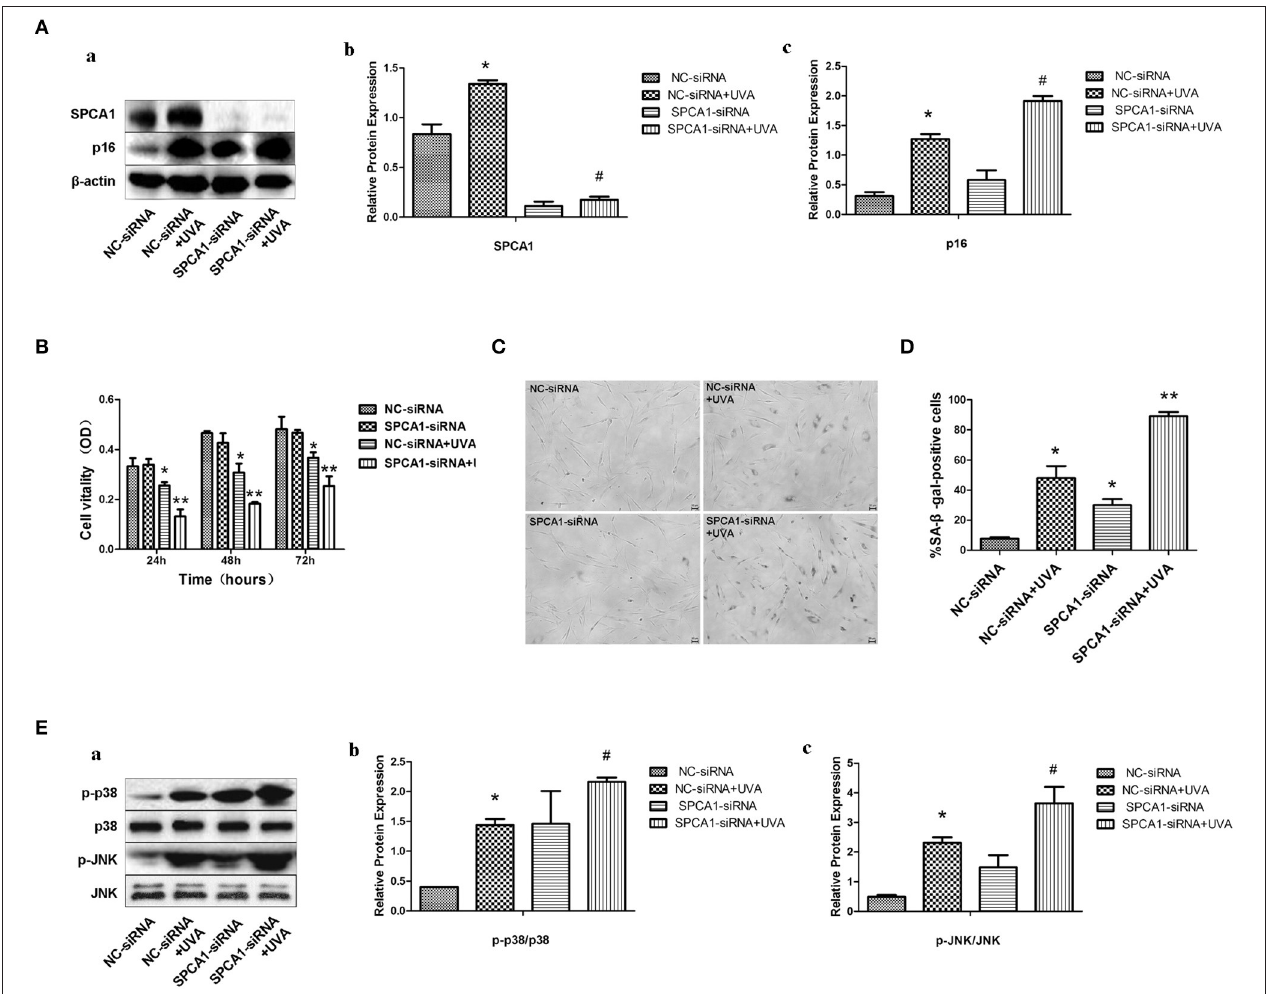
FIGURE 3 | SPCA1 siRNA exacerbates UVA-induced senescence and phosphorylation of MAPK. (A) Western blot images and quantitative analysis show SPCA1 and p16 protein expression in control and UVA-irradiated HDFs, with or without SPCA1 siRNA transfection. * P < 0.05 vs. NC-siRNA; # P < 0.05 vs. NC-siRNA + UVA. Data are representative of three independent experiments. (B) Cell vitality determined by MTT analysis under indicated conditions. * P < 0.05 vs. NC-siRNA; ** P < 0.05 vs. NC-siRNA + UVA. (C,D) Senescence-associated β -galactosidase (SA- β -gal) activity of cells under the indicated conditions. Representative images are shown (scale bar = 200 µ m). The percentages of SA- β -gal-positive cells under each condition are presented as the mean ± standard deviation of three independent experiments. * P < 0.05 vs. NC-siRNA; ** P < 0.05 vs. NC-siRNA + UVA. (E) Western blot images and quantitative analysis show phosphorylation of p38 and JNK in control and UVA-irradiated HDFs, with or without SPCA1 siRNA transfection. * P < 0.05 vs. NC-siRNA; # P < 0.05 vs. NC-siRNA + UVA. Data are representative of three independent